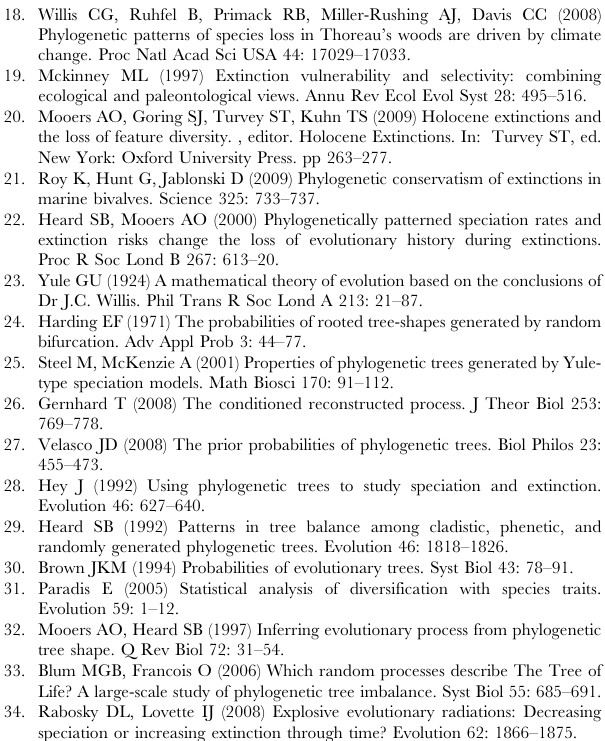
subclades, which are found near the tips of a phylogeny with the trait displaying an excessive phylogenetic signal. Figure S2 Traitgrams and the two measures of phylo- genetic signal. The three traitgrams show the evolution of a continuous trait evolving under different phylogenetic signals. The x-axis represents a continuous scale of species’ trait values and node depths represent the phylogenetic edge lengths. Traitgram in A) represents the evolution of a trait with no phylogenetic signal ( l =0), while traitgrams in B) and C) represent the evolution of a trait under the perfect BM model and when evolution exceeds the perfect BM model ( l =1 and l = 10), respectively. Each case of evolution is represented by two independent measures of phylogenetic signal (Pagel’s l and Blomberg’s K statistic). Figure S3 Quantifying percentage difference in project- ed PD with phylogenetic clustering in 128-tip Yule trees. A) mean p(ext) = 0.25, B) mean p(ext) = 0.5, and C) mean p(ext) = 0.75. Data points in percentage denote the amount of additional loss of projected PD (relative to random extinction) with increasing phylogenetic clustering. Dashed line indicates that loss under random extinction. Error bars around points represent the 95% confidence interval with a sample size of 1000 trees. Note differences in vertical axes. Figure S4 The additional loss of PD as function of phylogenetic clustering in 64-tip balanced Yule trees. A) mean p(ext) = 0.25, B) mean p(ext) = 0.5, and C) mean p(ext) = 0.75. Data points in percentage denote the amount of additional loss of projected PD (relative to random extinction) with increasing phylogenetic clustering. Dashed line indicates that loss under random extinction. Error bars around points represent the 95%